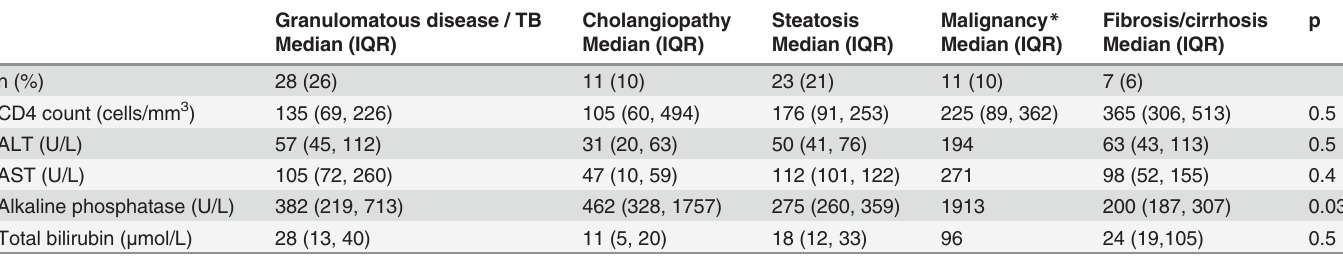
Table 2. Primary histopathology and laboratory fi ndings for HIV-infected patients. Granulomatous disease /